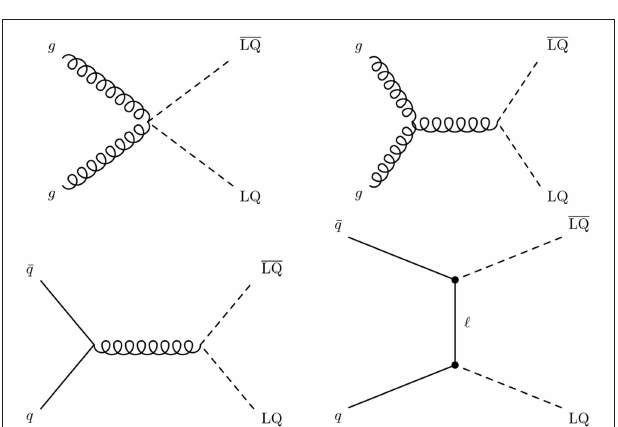
TABLE 1 | List of scalar and vector LQs.